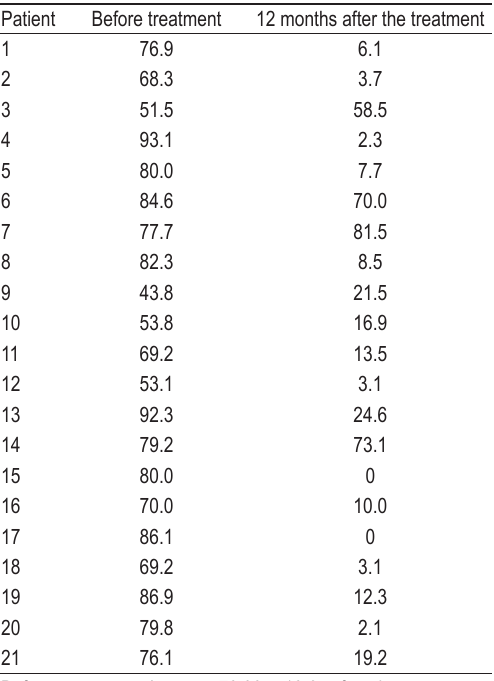
TABLE 3. SPADI score before and 12 months after Prolotherapy treatment Patient Before treatment